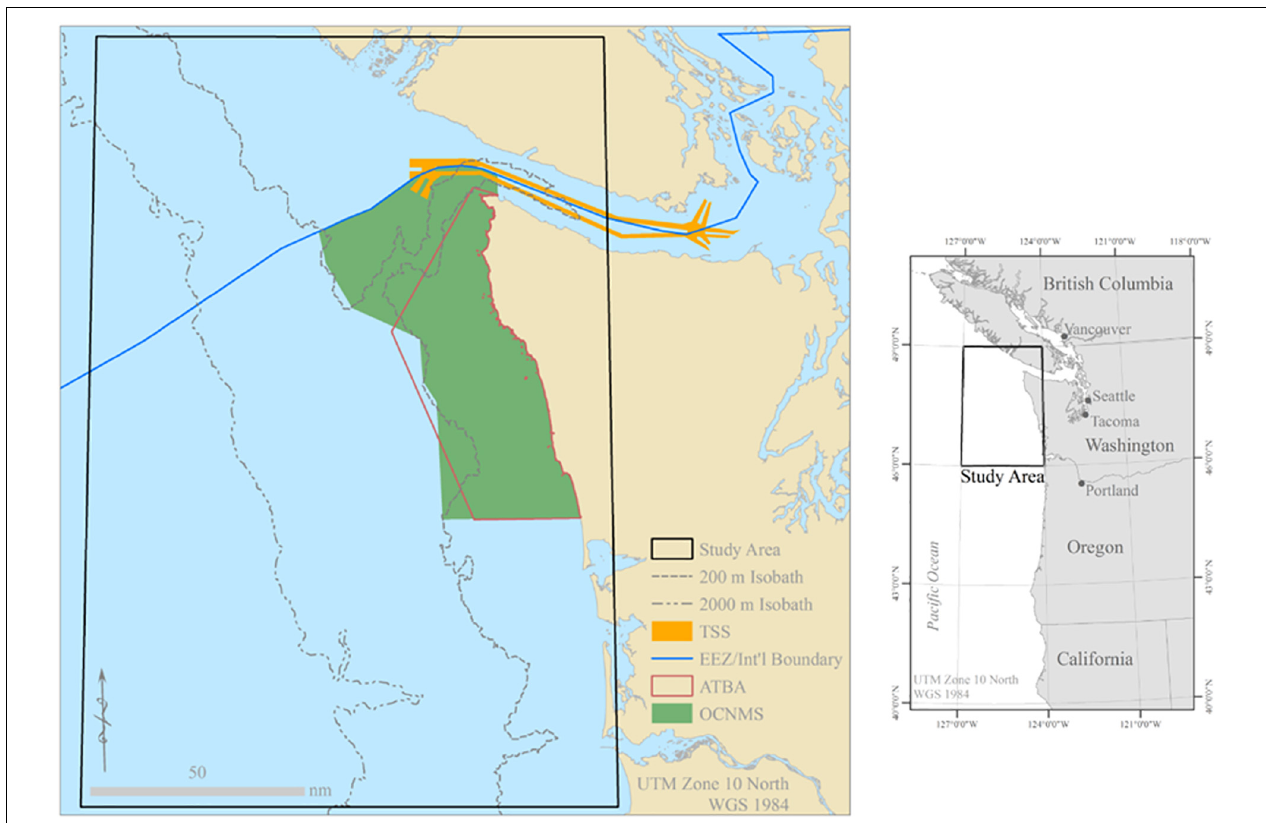
FIGURE 1 | Bathymetry and administrative areas in the study area along the Pacific Northwest coast including Washington state in the United States and southwest Vancouver Island in Canada. Note: Traffic Separation Scheme (TSS), Exclusive Economic Zone (EEZ), Area To Be Avoided (ATBA), Olympic Coast National Marine Sanctuary